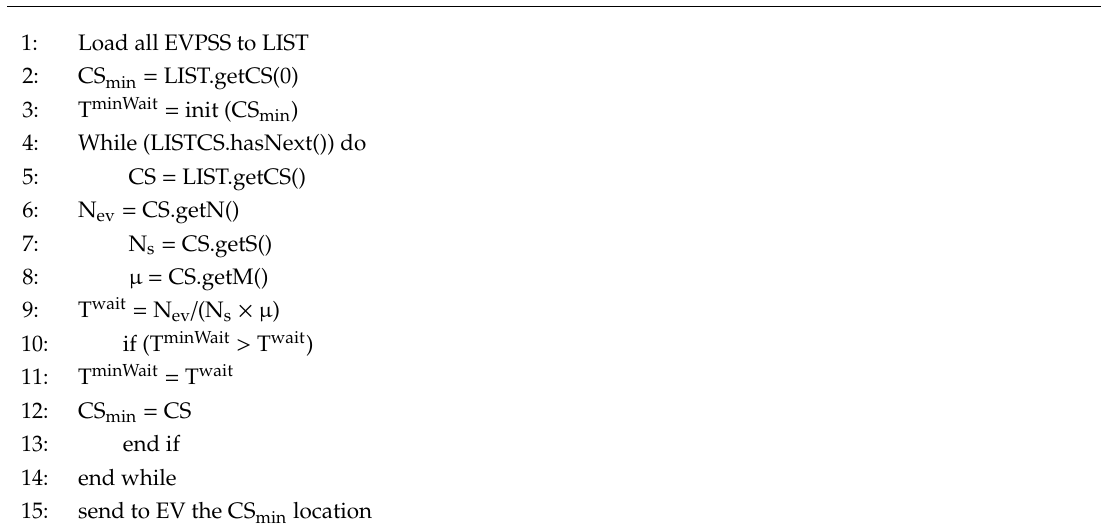
Algorithm 2: Decision of Selection the